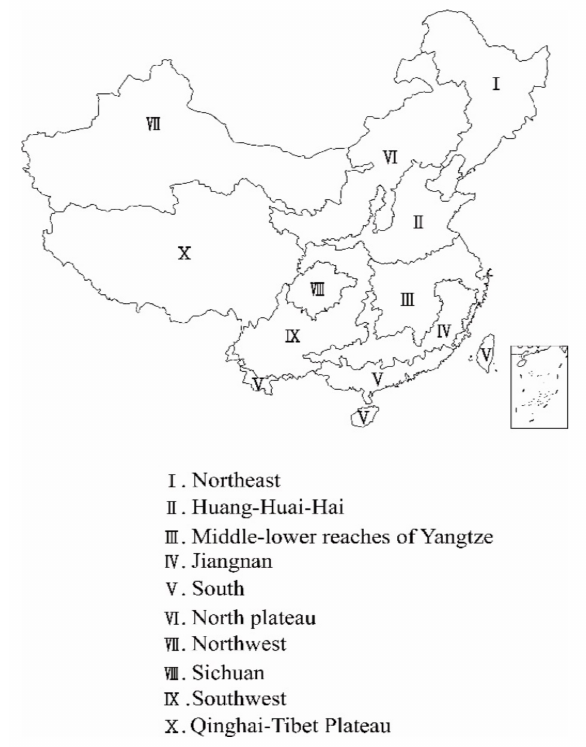
Figure A1. Agro-ecological zones of China